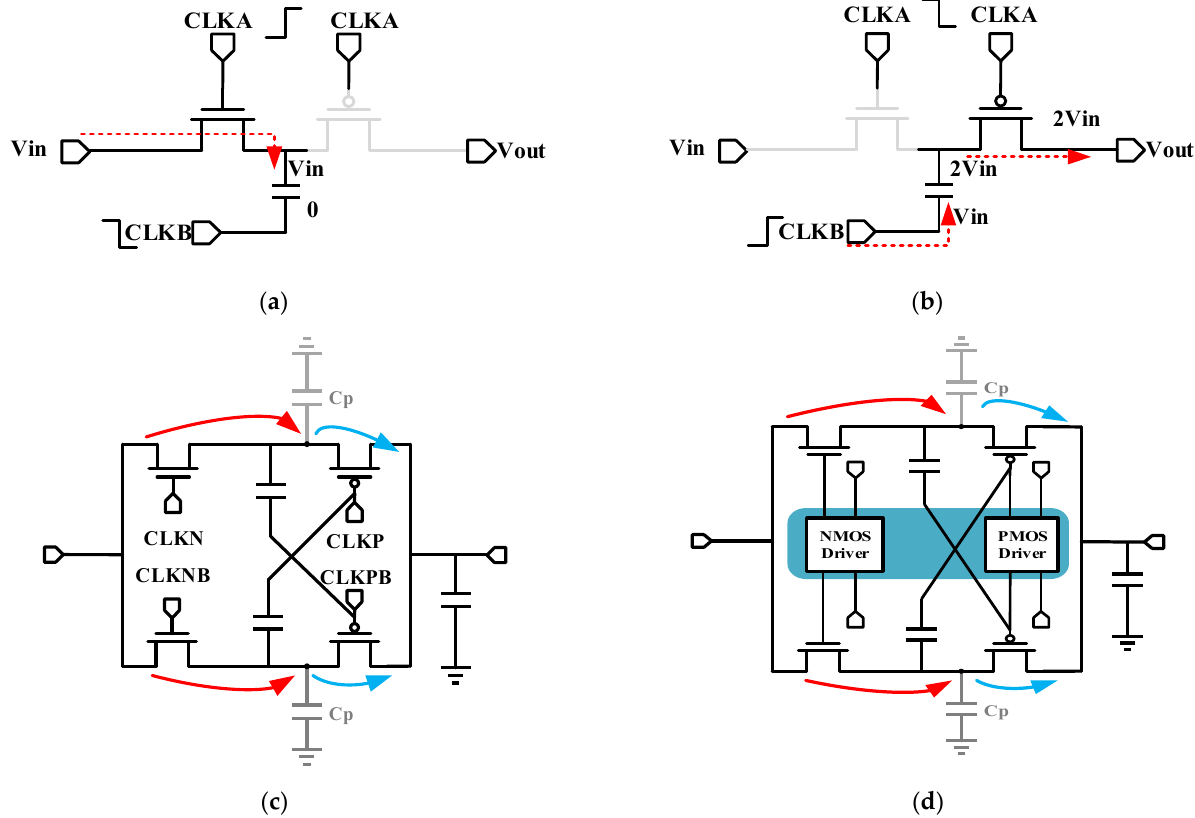
Figure 6. ( a ) A single charge pump voltage transfer schematic; ( b ) As single charge pump charging schematic; ( c ) Circuit diagram of Cross-coupled CMOS charge pump; ( d ) Circuit diagram of Cross-coupled CMOS charge pump with drivers.